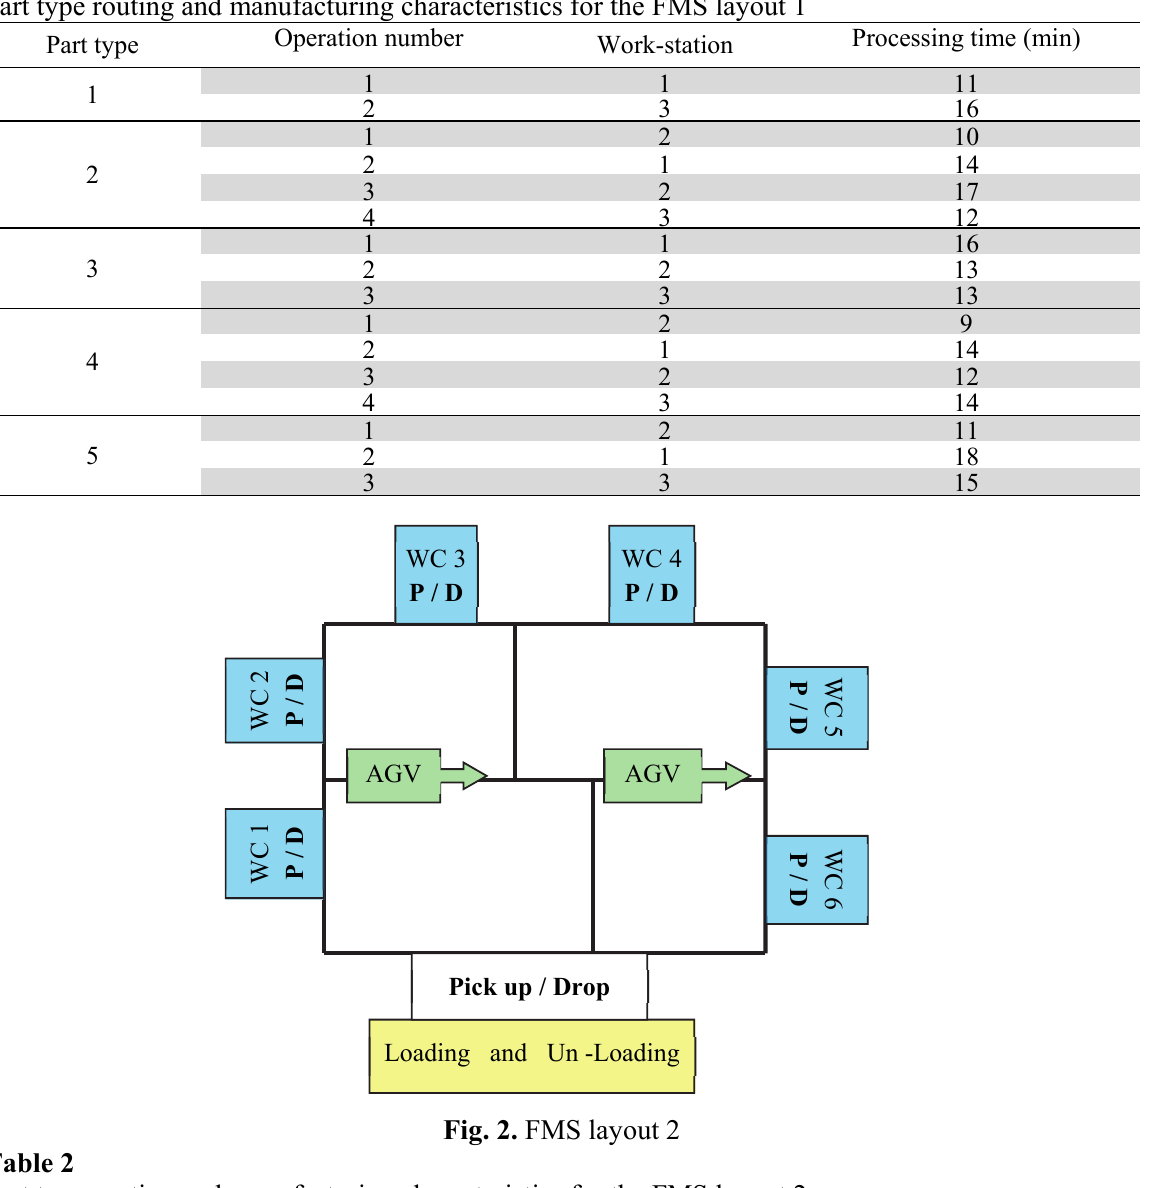
Part type routing and manufacturing characteristics for the FMS layout 2 Part type Operation